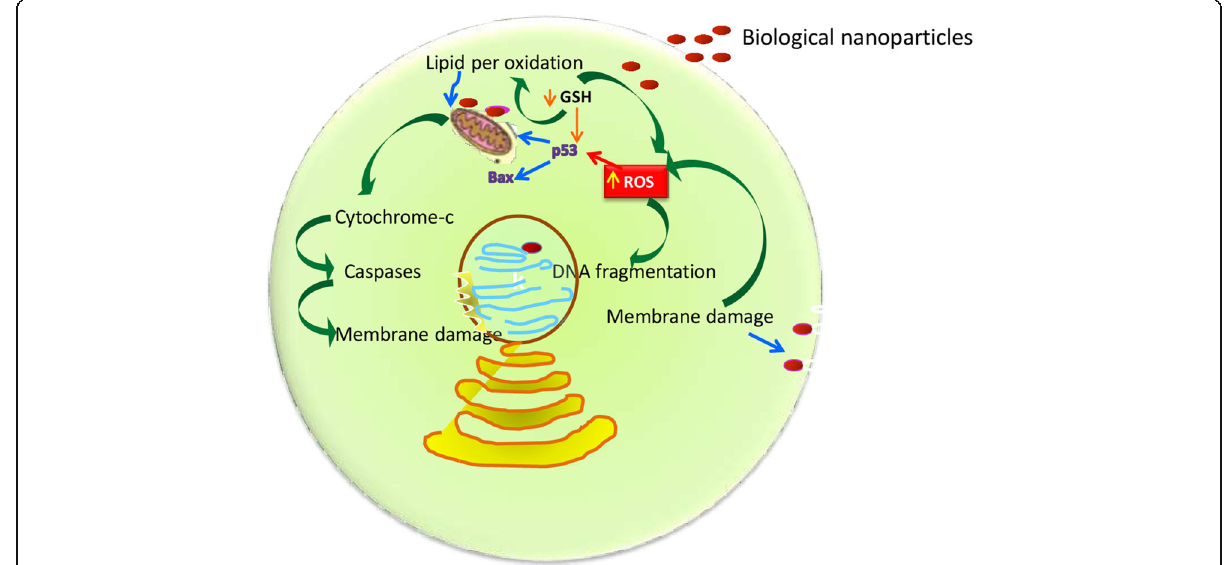
Fig. 4 Cytotoxic mechanism of biological